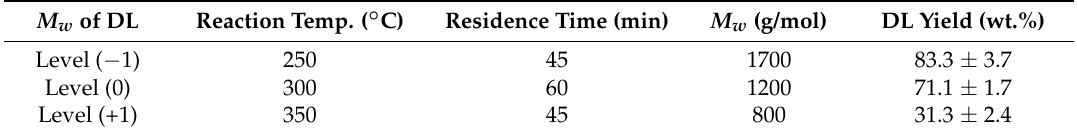
Table 1. GPC-UV derived relative M w and percent yield of the three depolymerized lignin levels. M w of DL Reaction Temp. ( ◦ C) Residence Time (min) M w (g/mol) DL Yield (wt.%) Level ( −